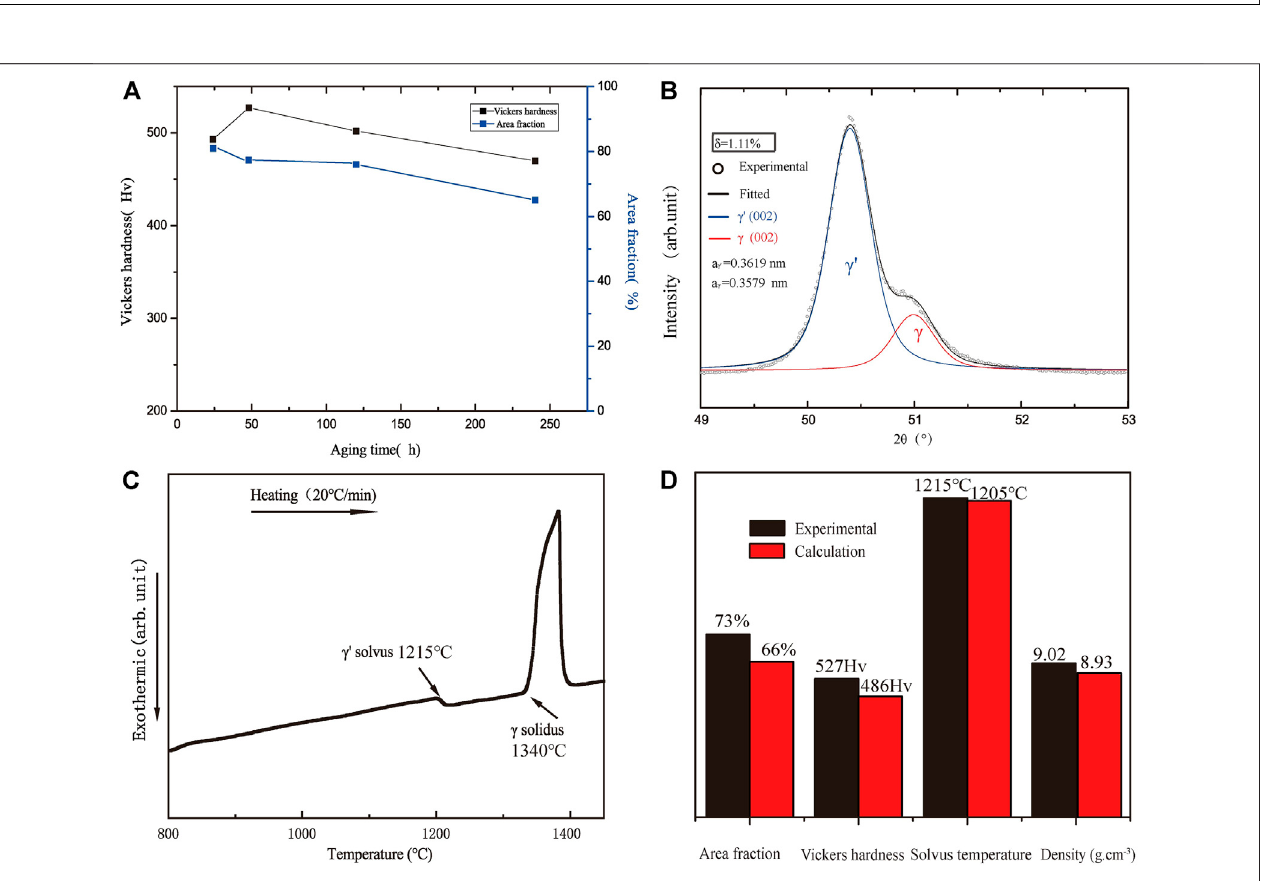
Frontiers in Materials |